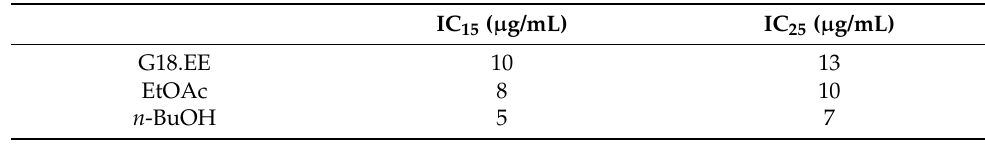
Table 3. IC 15 and IC 25 intermediate values selected for G18.EE and n -BuOH and EtOAc fractions against melanoma cells. against melanoma cells.